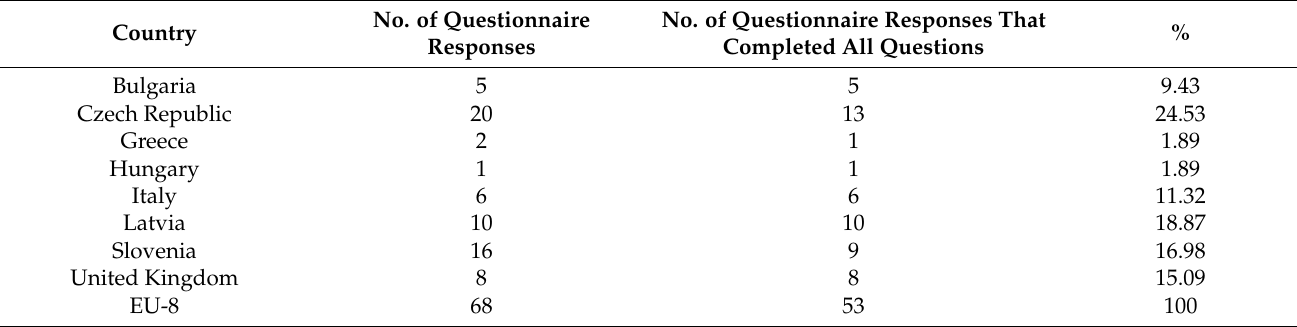
Table 1. Questionnaire responses by country.